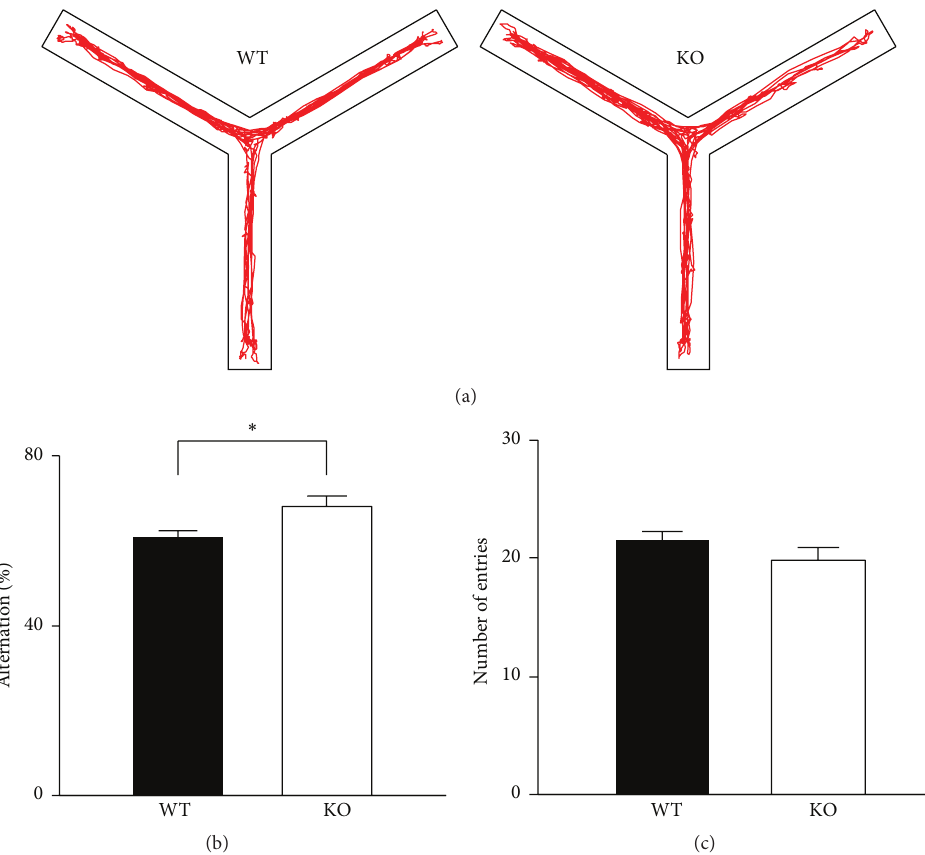
Figure 2: Spatial working memory of CB2R KO mice is enhanced when assessed with a spontaneous alternation test in a Y-maze. (a) Representative tracking of mouse movement for 3 min in a Y-maze. Consecutive entries into three different arms were counted as an alternation. (b) KO mice displayed a higher rate of spontaneous alternation compared with WT mice. ∗ 𝑃 = 0.012 , 𝑡 -test. (c) The total number of arm entries was not significantly different between the two strains. Error bars represent